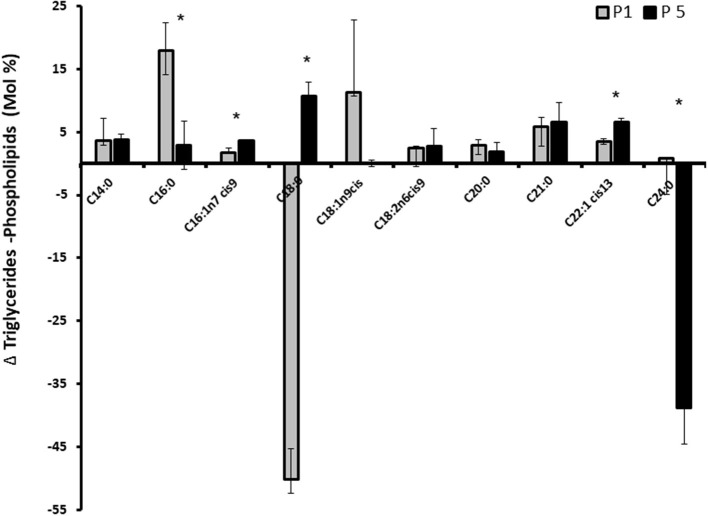
Effect of progesterone on mammary epithelial cells fatty acids profile. Mammary epithelial cells were treated with progesterone at 1 and 5 ng/ml (P1 and P5, respectively) for 24 h. After treatment, cells were harvested and their fatty acid composition was determined. The concentration of each fatty acids is presented as the delta between its concentration in triglyceride and its concentration in the phospholipid fraction. Positive values indicate greater utilization for fat synthesis (triglyceride) whereas negative values indicate greater utilization for membrane (phospholipid) synthesis. Data are presented as mean ± SD. Asterisk indicates significant differences in the level of p ≤ 0.05.